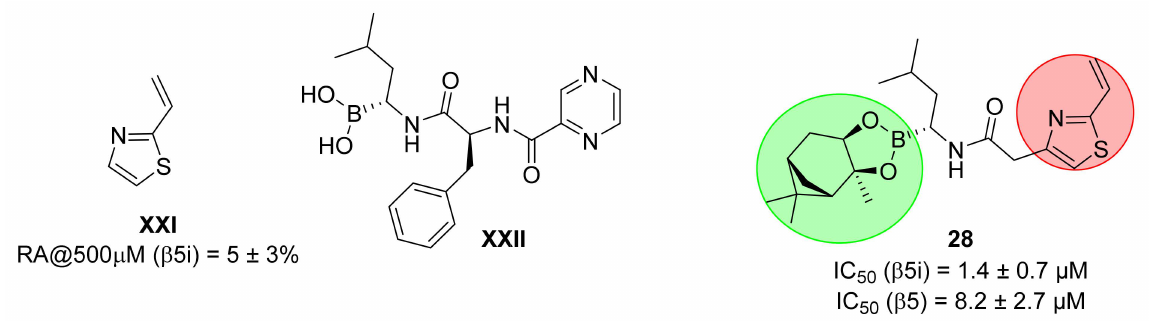
Figure 4. Structure of 2-vinylthiazole ( XXI ), bortezomib ( XXII ), and the designed compound 28 . The boron-bearing warhead is marked with green circle and the 2-vinylthiazole is marked with red